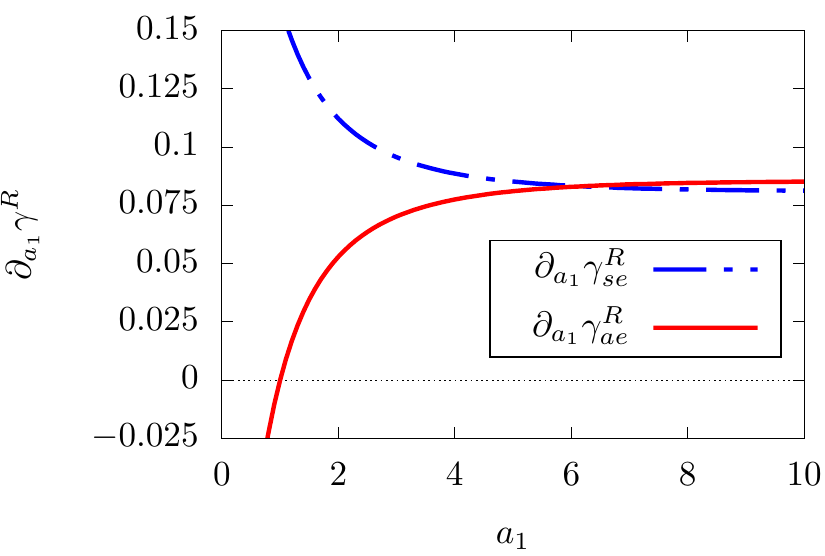
Figure 19 . The quantity ∂ a γ R is plotted with respect to varying a 1 for accelerated atoms in se 1 thermal background considering Rindler modes, depicted by dash-dotted blue line. The quantity ∂ a γ R is plotted with respect to varying a 1 for accelerated atoms in thermal background considering ae 1 Rindler modes in (1 + 3) dimensions, depicted by solid red line.